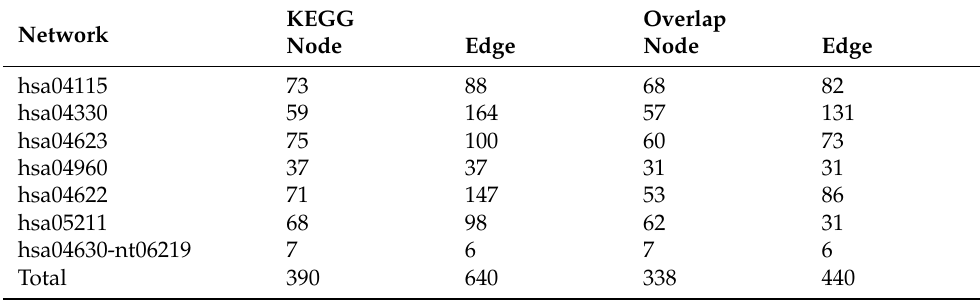
Table 1. Summary of analyzed